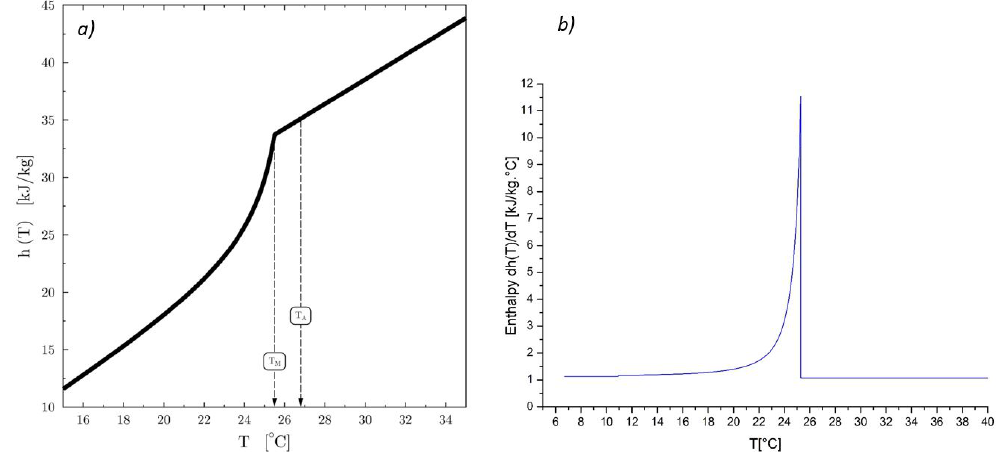
Figure 9. ( a ) Enthalpy curve vs. temperature, ( b ) Derivative of the enthalpy vs. temperature